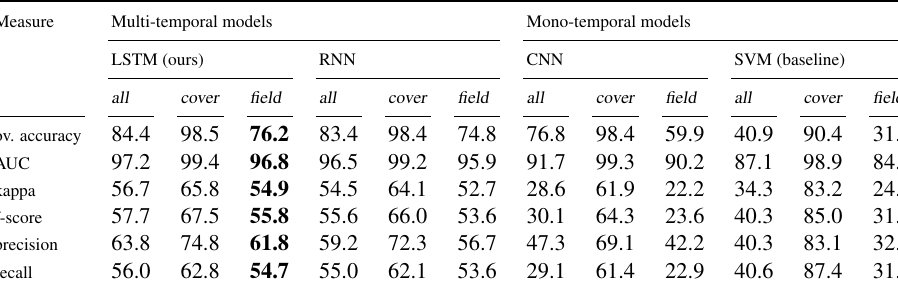
Table 1. Performance evaluation of our proposed LSTM-based method in comparison to standard RNNs and mono-temporal baselines based on CNNs and SVMs. As cover classes ( i.e., , cloud , cloud shadow , water , and snow ) are usually comparatively easy to recognize, we restrict our evaluation to unbiased performance measures with respect to the remaining field classes, Measure